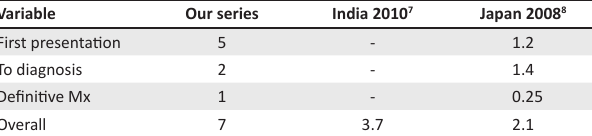
TABLE 3: Comparison to other parts of the world (in months).